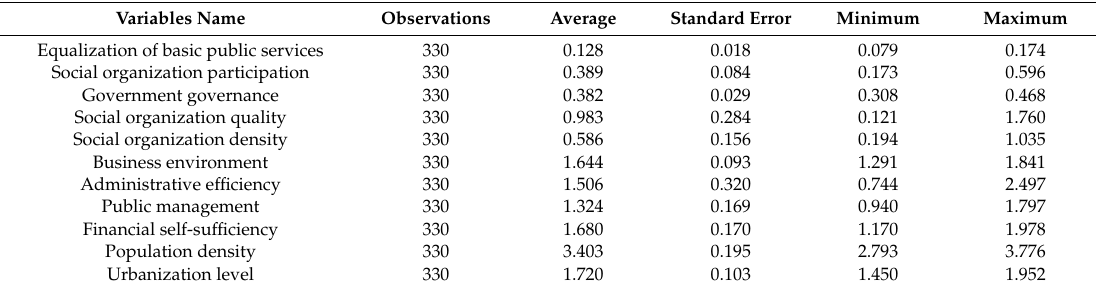
Table 3. Descriptive statistics.